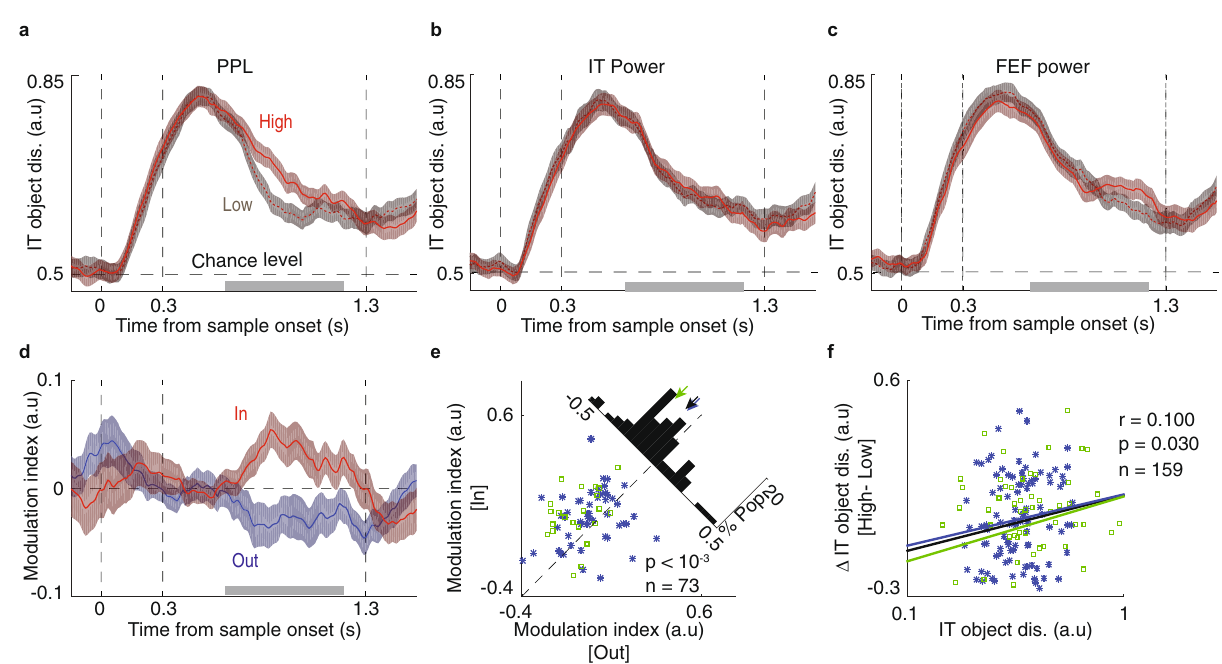
Fig. 5 Enhancement of object coding by IT spiking activity during high beta PPL. a Object discriminability was greater on trials with high beta PPL. Time- course of the object discriminability values for High (light red) vs. Low (dark red) PPL trials for object-selective IT units ( n = 74 units). Data were smoothed within a window of 1 ms and represented as mean ± SEM. Gray bar in a – d indicates portion of delay period used for analysis in e , f . b , c Object discriminability does not re fl ect beta power within IT ( b , n = 75 units) or FEF ( c , n = 72 units). Time-course of the object discriminability values for High (light red) vs. Low (dark red) beta band power trials for object-selective IT units. Smoothing and error bar as in a . d Plot shows the time-course of the modulation index of object discriminability (High vs. Low PPL trials), for In (red) and Out (blue) conditions ( n = 73 units). Data were smoothed with a window of 1 ms and represented as mean ± SEM. e Scatter plot illustrates the modulation index of object discriminability (High vs. Low PPL) during the delay period for In vs. Out conditions. The histogram in the upper right shows the difference between In and Out ( n = 73 units, p = 0.00018, Wilcoxon ’ s signed-rank test, two-sided). M1 plotted in blue and M2 in green. f Scatter plot shows the correlation between discriminability for each IT unit ( x -axis) and the difference in discriminability for that unit between high and low beta PPL trials ( y -axis, n = 159 units, Kendall correlation, r = 0.100, p = 0.030). Lines show fi ts for individual monkeys (blue, green) and combined data